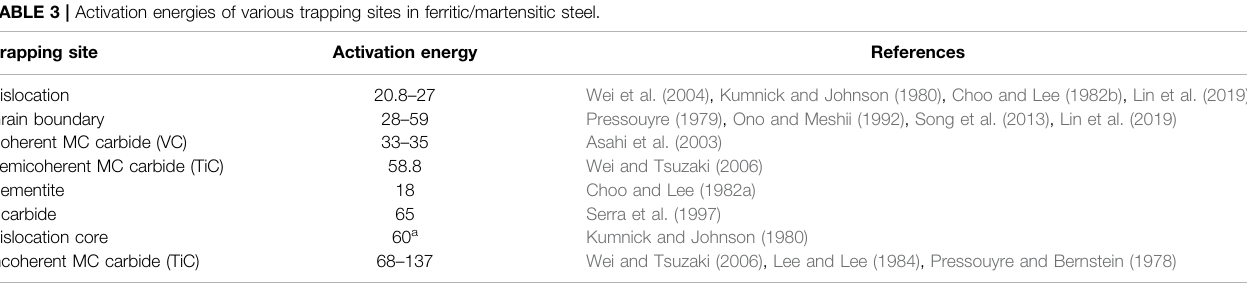
TABLE 3 | Activation energies of various trapping sites in ferritic/martensitic steel. Trapping